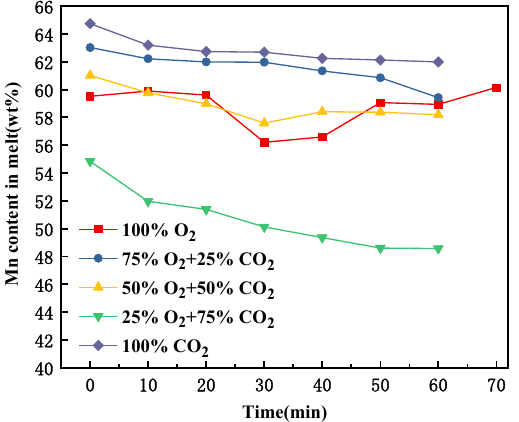
Figure 4. Variation in manganese content with time when blowing different CO 2 -O 2 mixtures. Table 4. The manganese yield of formal experiments.